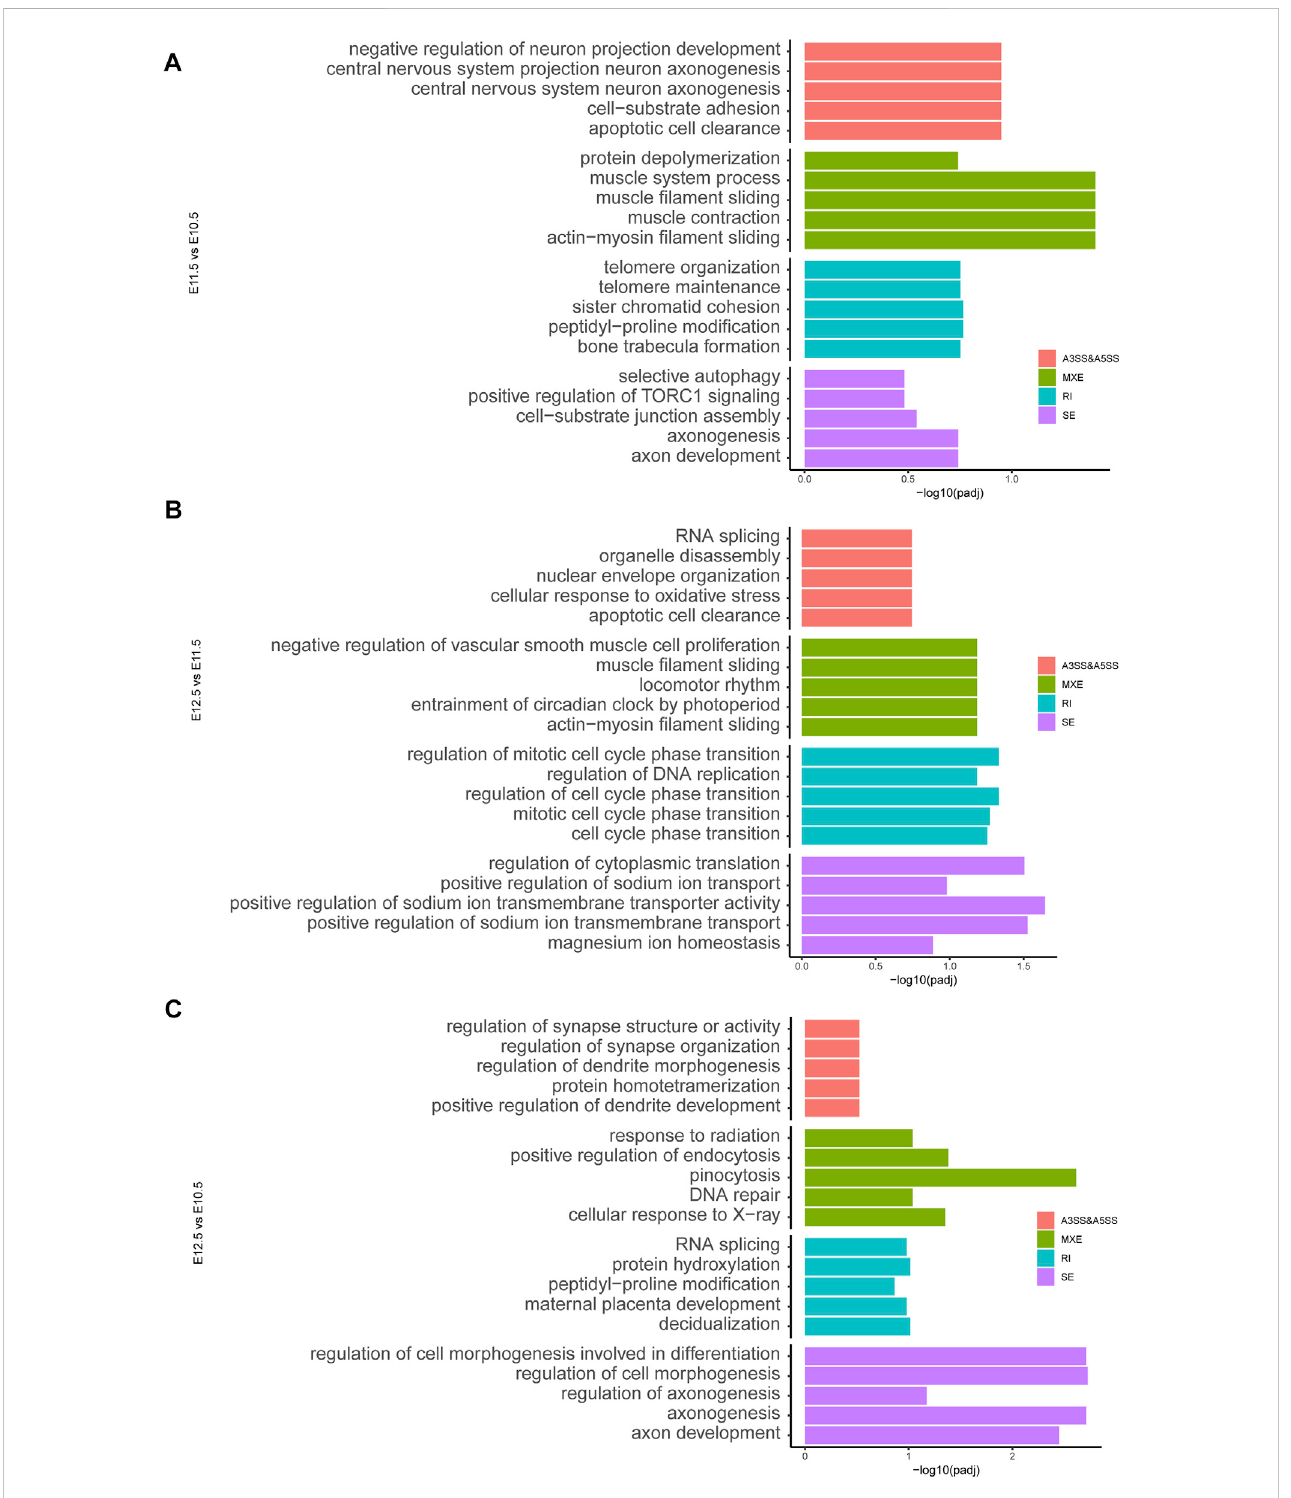
FIGURE 7 ene ontology analysis showing the top fi ve ranked terms for alternatively spliced genes among comparison groups (A) E11.5 vs. E10.5, (B) E12.5 vs. E11.5, and (C) E12.5 vs. E10.5.